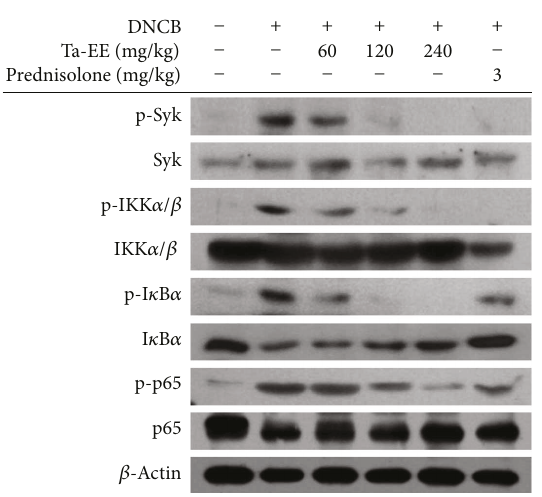
Figure 6: E ff ect of Ta-EE on the activation of in fl ammatory signaling molecules. Phospho- or total form levels of p65/NF- κ B, I κ B α , IKK α / β , Syk, and β -actin from skin tissue of DNCB- induced AD mice were detected by immunoblotting analysis with phospho-speci fi c or total protein antibodies from total cell lysates.